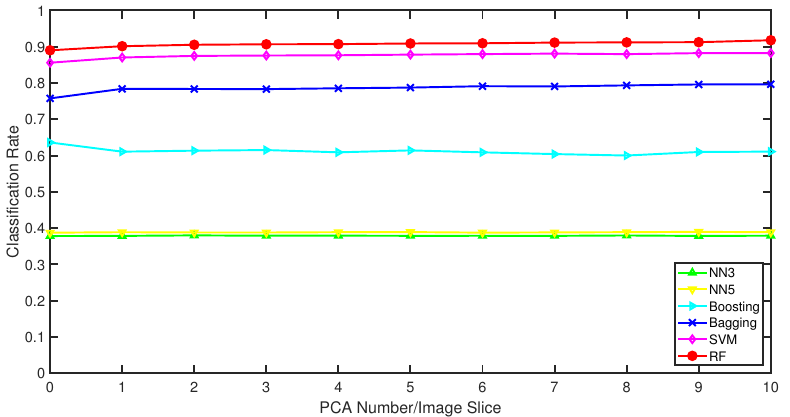
Figure 11. This figure demonstrates the function of the PCA number per image or image slice and the classification rate of the four categories of WiFi signals under the condition of various